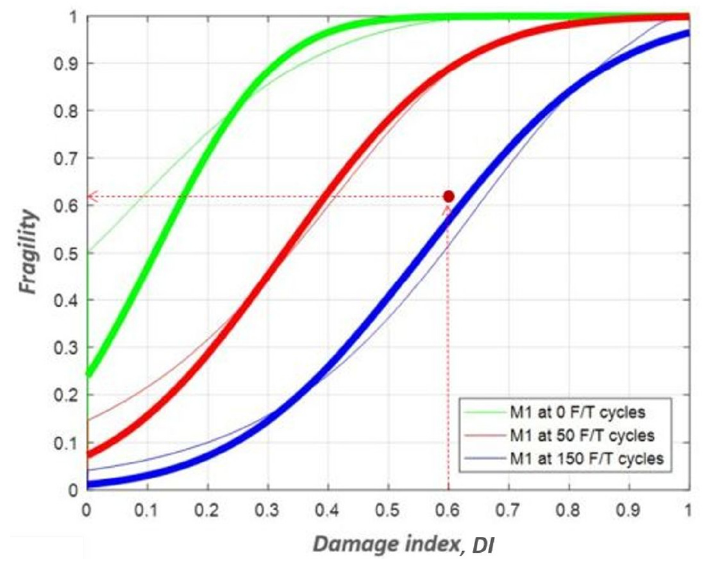
Figure 8. Estimated probability for the damage index, DI, not exceeding a value of 0.6 in 20 years for an existing masonry brick building in a hypothetical scenario. The graph from Figure 5 was applied.